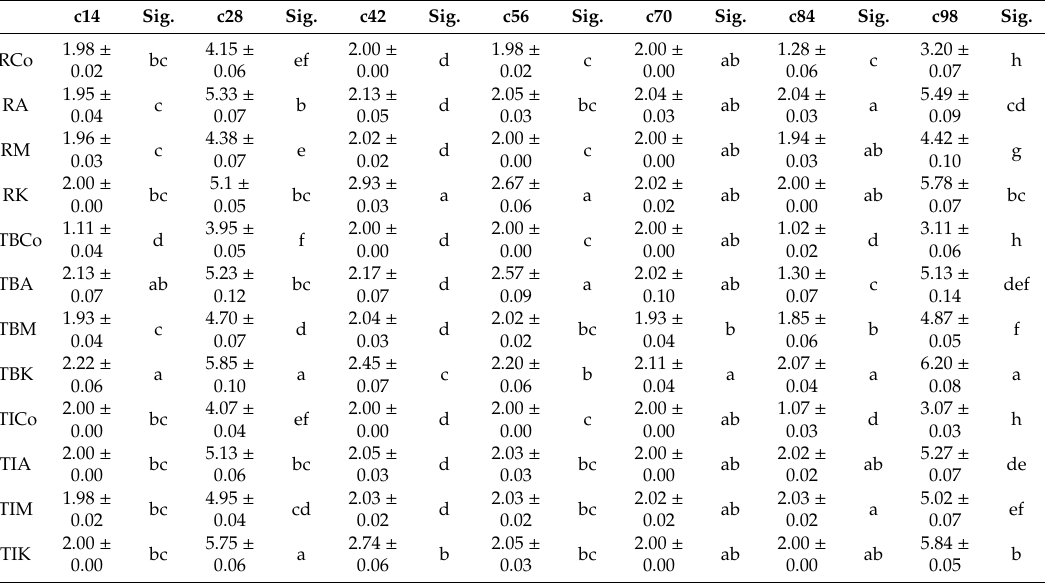
Table 5. Blackcurrant variety-specific increases in branches (cm) during the vegetation period. c14 Sig. c28 Sig.